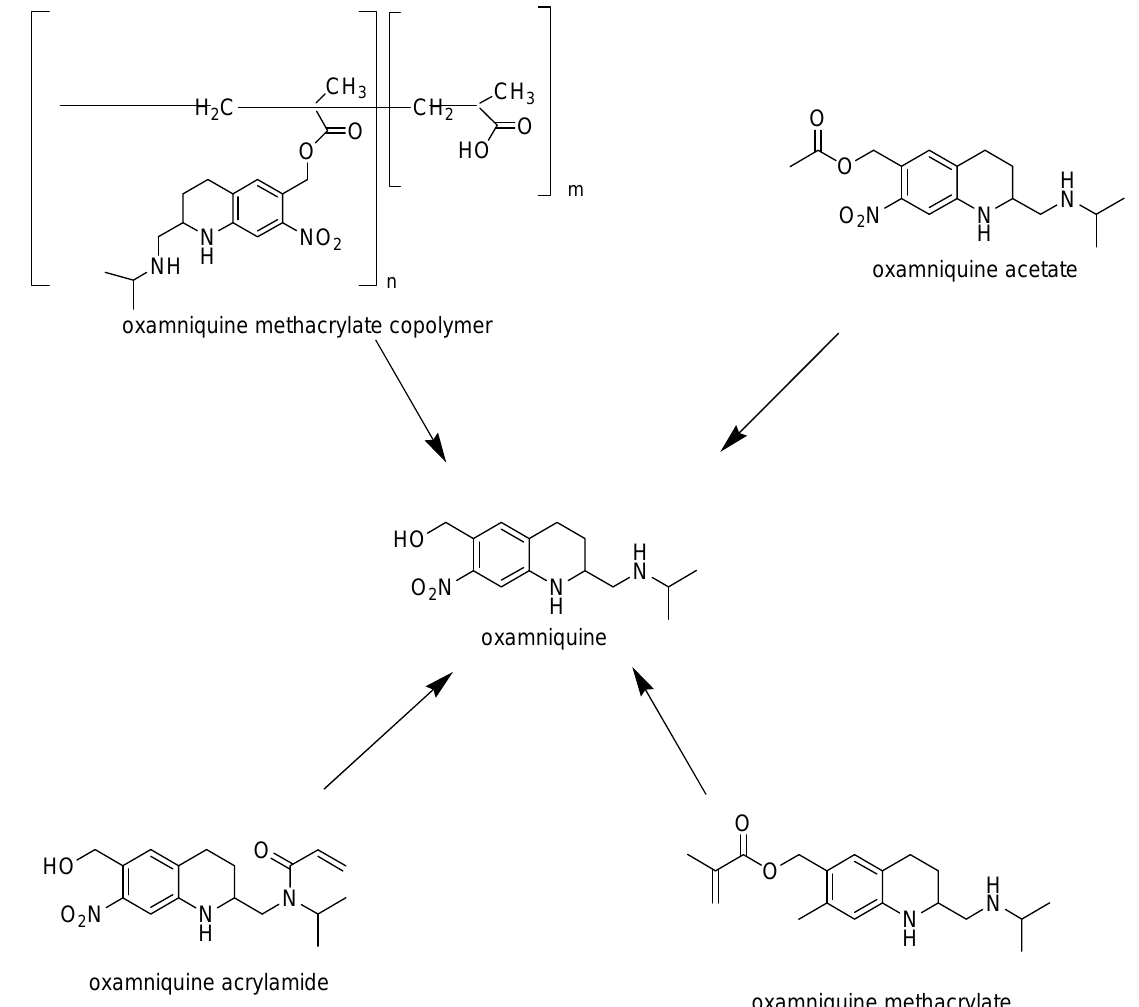
Figure 31 : Structures and hydrolysis of prodrugs of